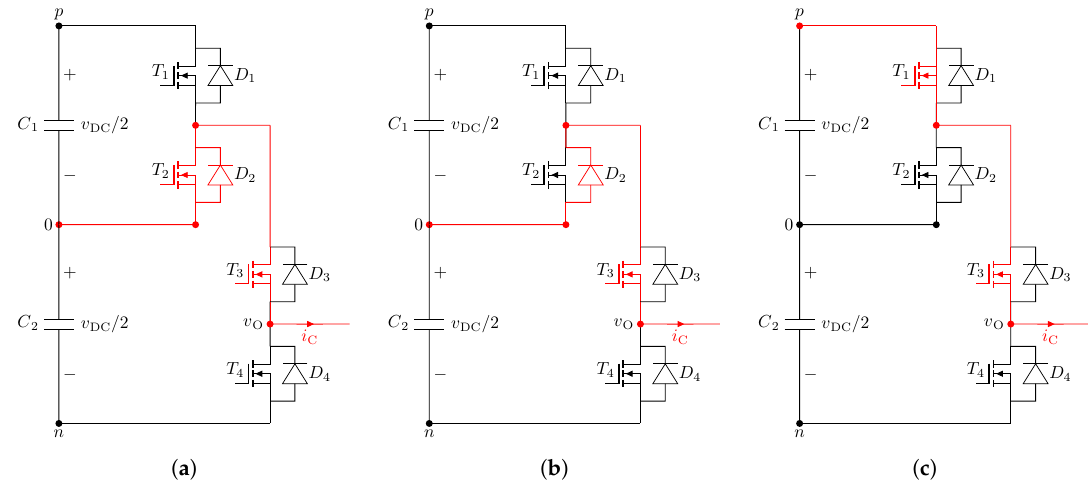
Figure 6. Current commutation , transition from switching state 0 to p for I C > 0. Current flow depicted in red. ( a ) Switching state 0 . ( b ) Blanking time (between T1 and T2 ) interval. ( c ) Switching state p